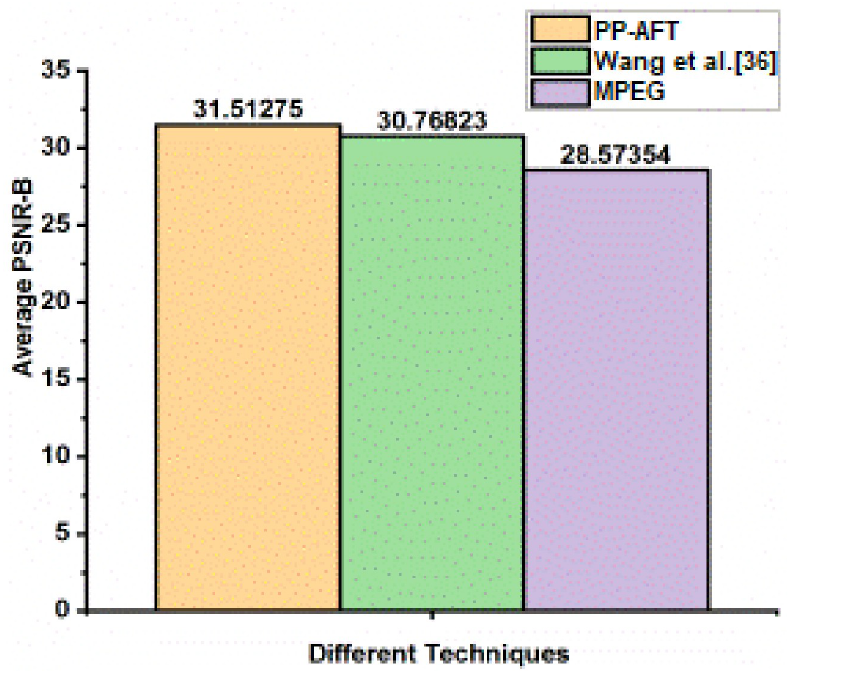
Fig 8. Average value of PNSR-B for different techniques.